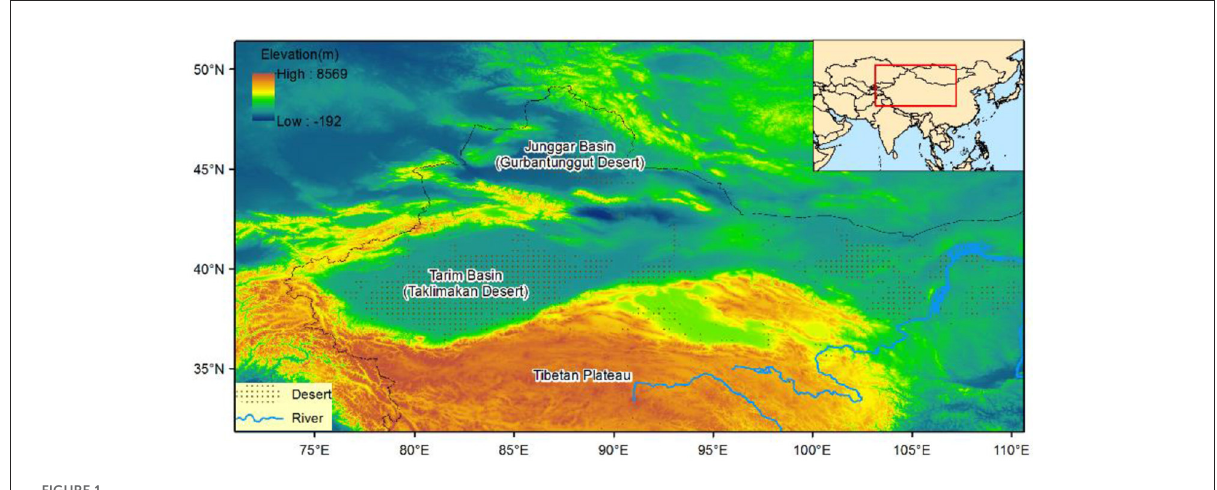
FIGURE1 Map showing the location of Northwest